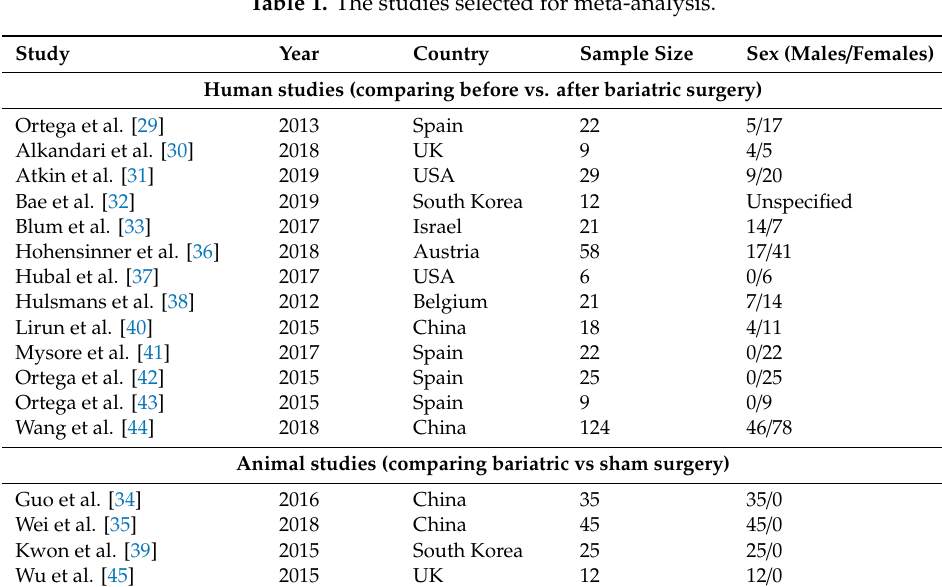
Figure 1. Flow diagram for study selection. Table 1. The studies selected for